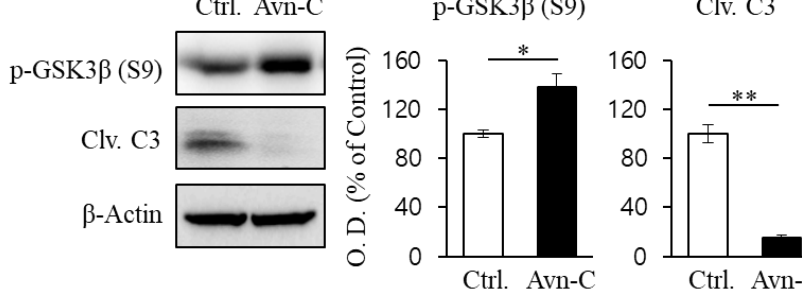
Figure 5. Avn-C restores LTP in Tg2576 mouse hippocampus. ( a ) LTP induction was triggered by high-frequency stimulation (HFS: 2 × tetanic stimulation at 100 Hz, 100 pulses; interstimulus interval, 30 s) in the hippocampal CA1 region of Tg2576 mice. The control group (open circles, 120.4 ± 2% of baseline) and Avn-C incubated group (closed circles, 145.9 ± 9% of baseline); n = 5 to 6 per group from 5 to 6 animals. ( b ) Representative Western blots (left) and group data (right) indicating altered p-GSK3 β (S9) and cleaved caspase-3 expression (Clv. C3) in the 50 µ M Avn-C-treated group compared with that in the control group; n = 4 per group from 4 animals. Data are expressed as mean ± S.E.M. Differences were considered significant at * p < 0.05, ** p < 0.01. Ctrl., control; fEPSP, field excitatory postsynaptic potentials; O. D., optical density; Avn-C, Avenanthramide C; LTP, long-term